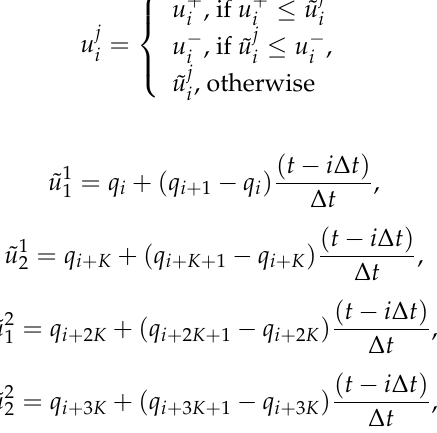
Figure 5. Control u 2